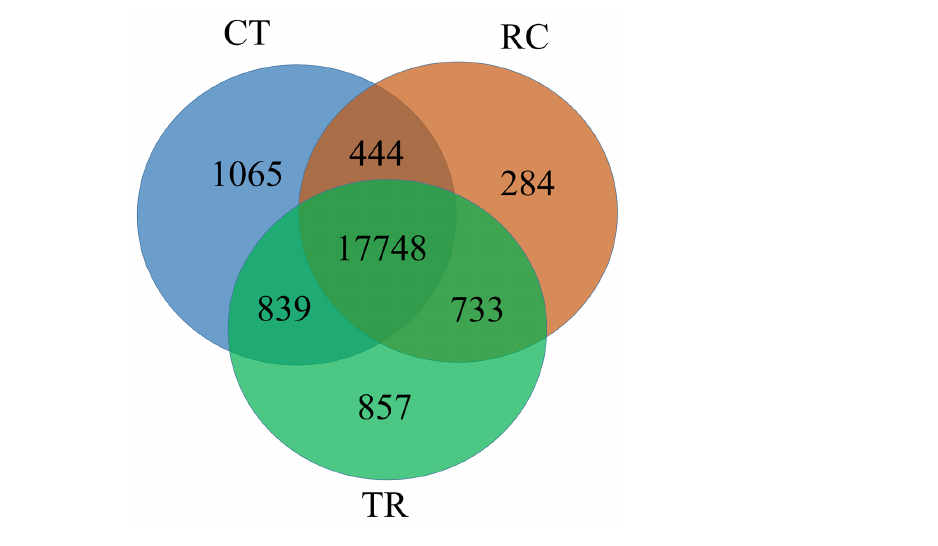
Figure 3. The Venn diagram between three treatments (CT, TR and RC). CT: Normal-temperature treatment. TR: Low-temperature treatment. RC: Recovery to normal-temperature treatment. The numbers in the figure represent the number of genes identified.